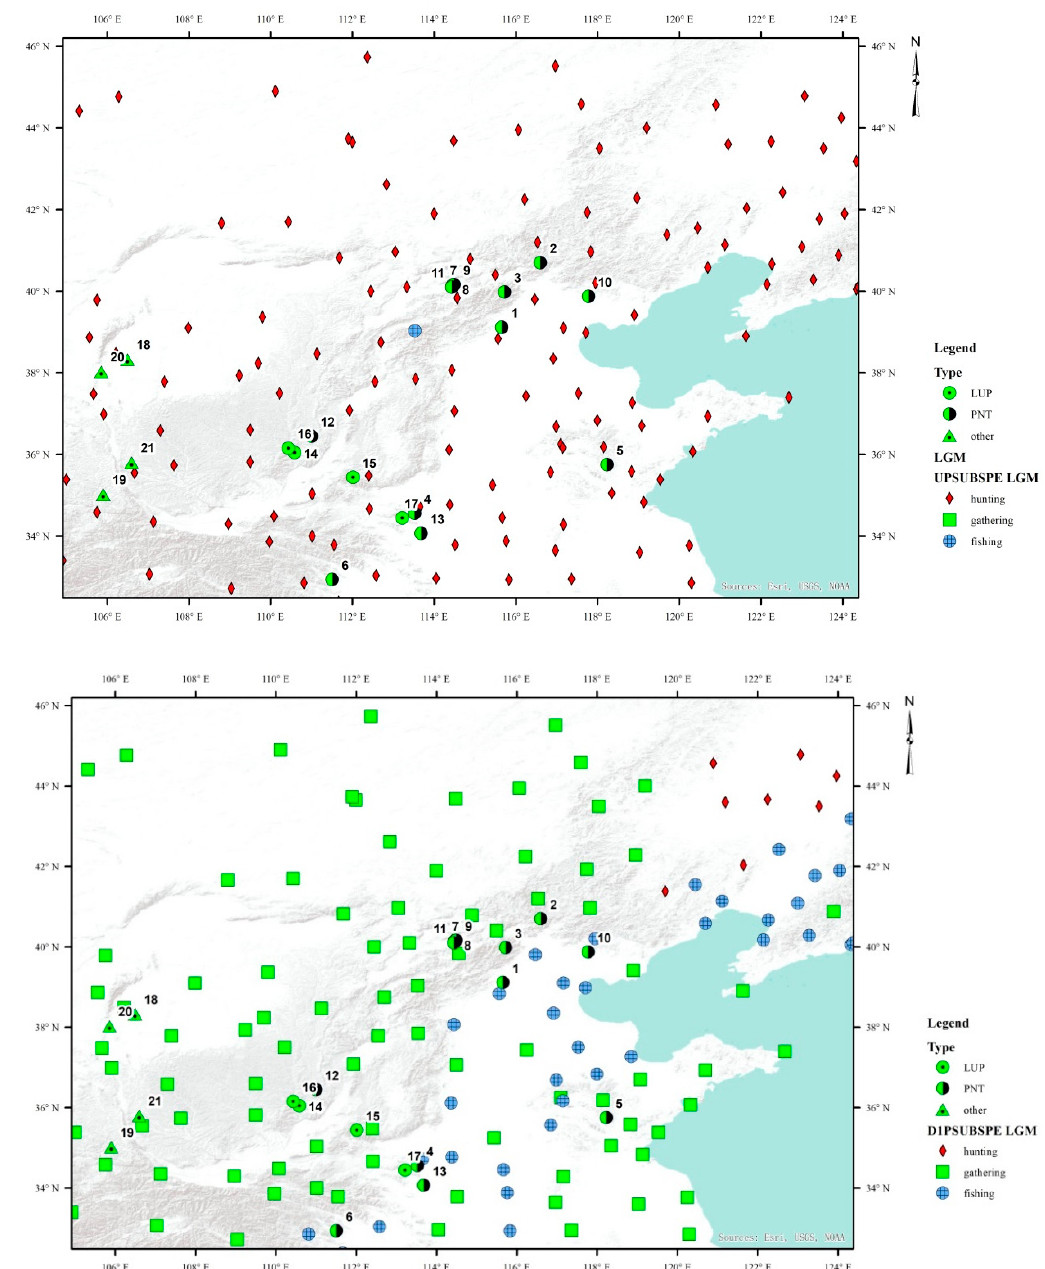
Figure 7. Archaeological sites dated to the Pleistocene to Holocene transition on the maps of projected unpacked and packed HG subsistence specialty (UPSUBSPE and D1PSUBSPE) in northern China under LGM climatic conditions.